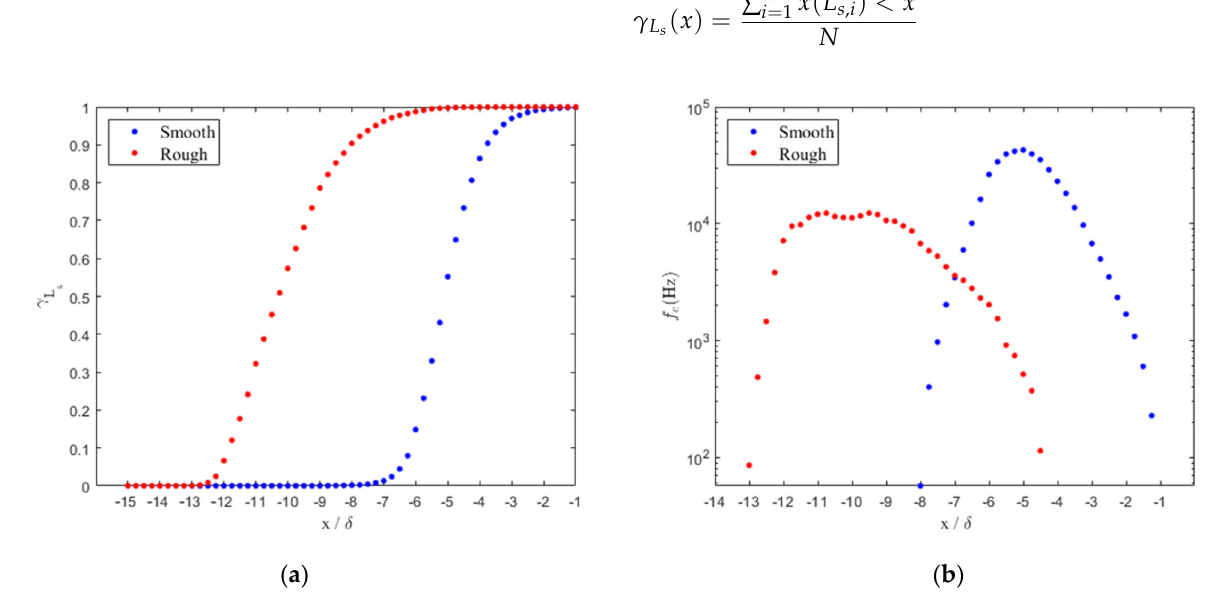
Figure 8. ( a ) Intermittency of the rough and smooth surfaces’ L s , and ( b ) zero-crossing frequency of the shock foot location for smooth and rough surfaces.